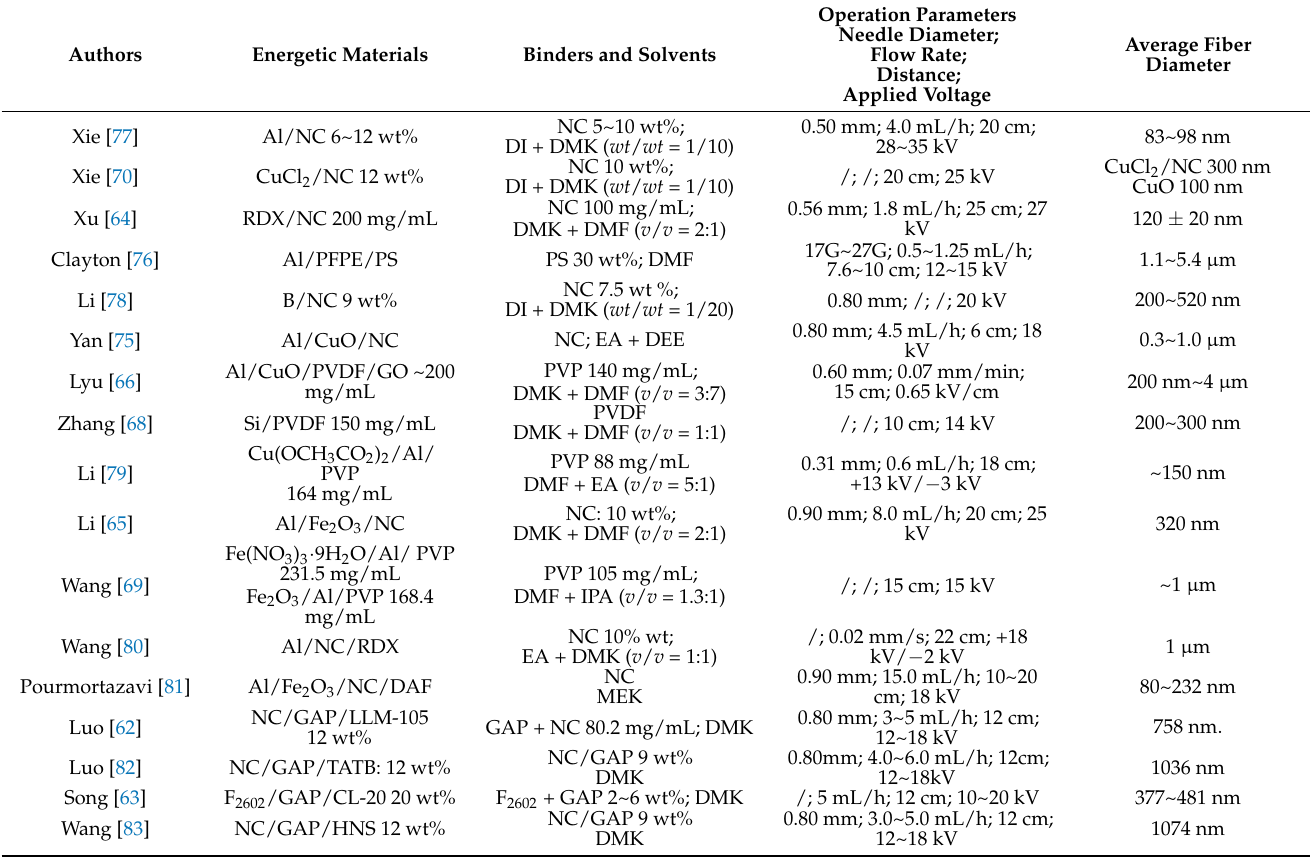
Table 3. Summary of energetic fibers fabricated by